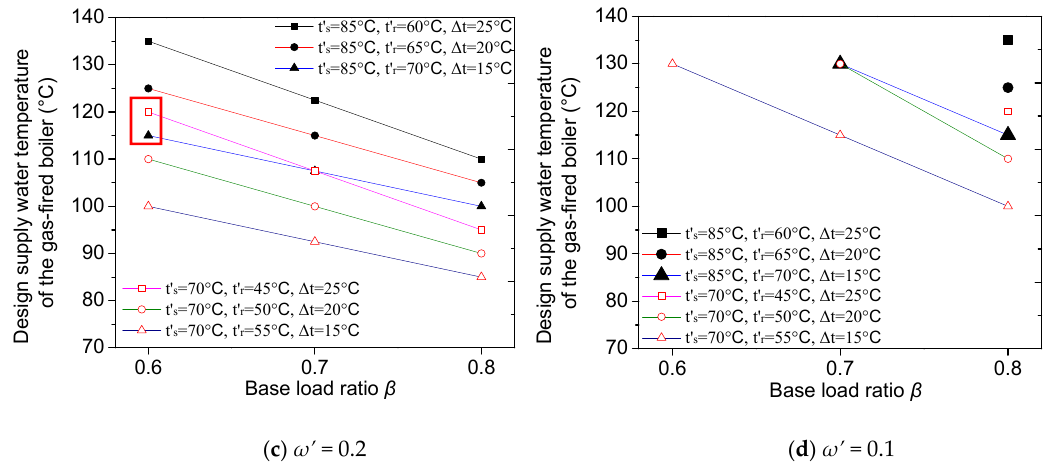
Figure 6. Variation of the design supply water temperature of the PB ( t (cid:48) s , p ) with di ff erent network temperature levels, base load ratio ( β ) and design peak shaving flow ratio ( ω (cid:48) ) for parallel connection.